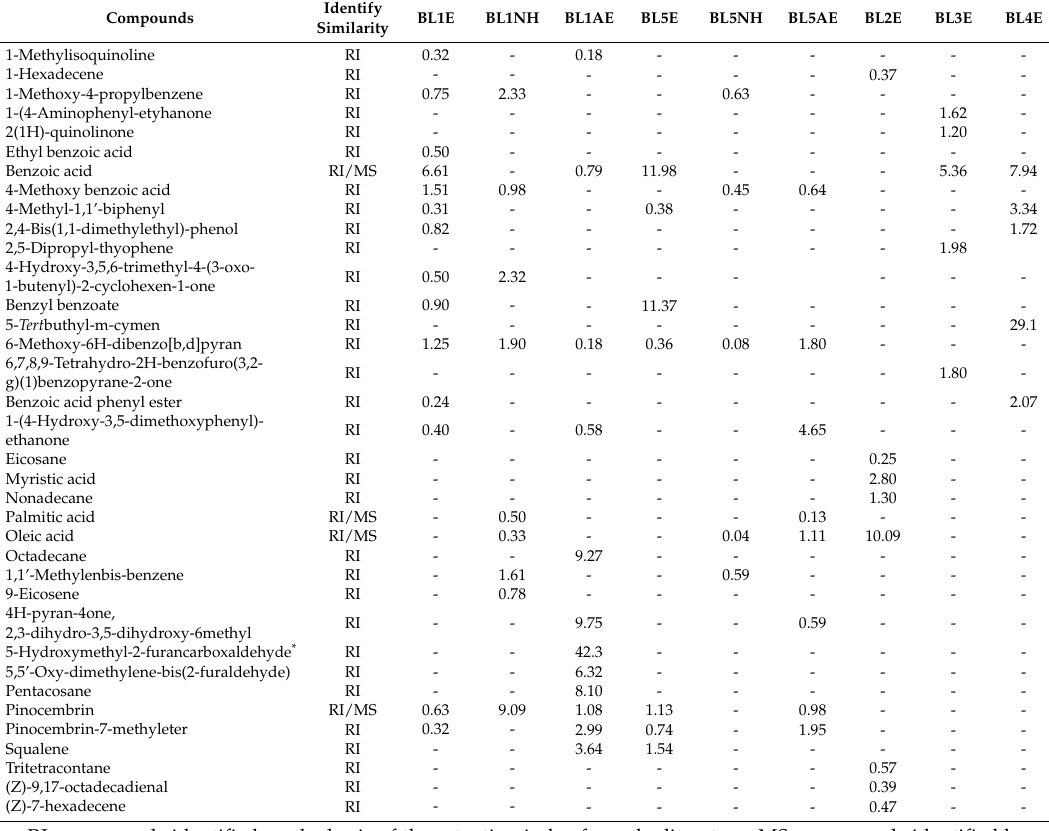
Table 1. GC/MS analyses of honey extracts and percentage of volatile compounds (% in one mg of sample). Compounds